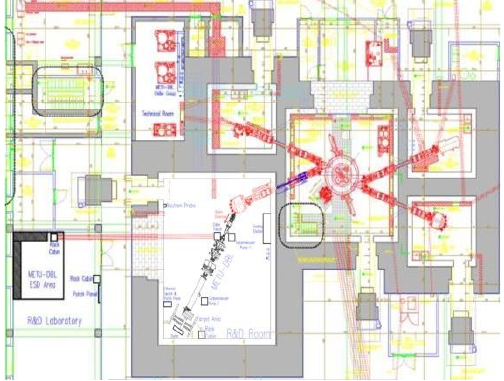
Fig. 1. The schematic design of TAEA SANAEM Proton Accelerator Facility. The cyclotron is seen in red on the right, where 4 arms extend out to 4 different irradiation rooms. The one on the lower left is the R&D room in which METU-DBL is shown in black. The connection between this R&D room and the control system in the R&D laboratory is provided by the underground trench shown here in red.